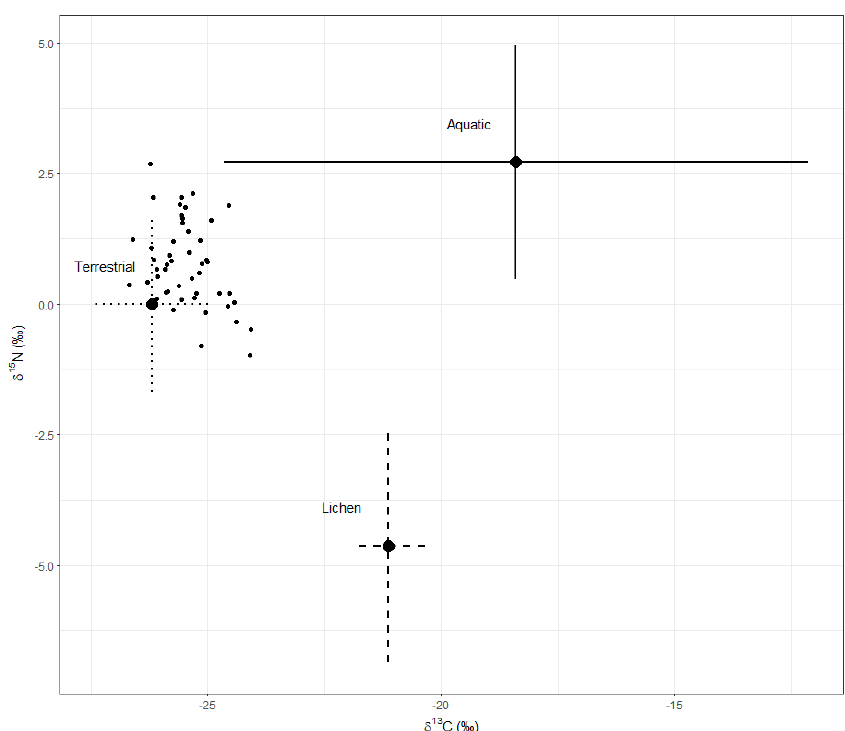
Figure 3. Mean ( ± SD) δ 13 C and δ 15 N in moose forage groups (sources) collected on Isle Royale, Michigan, USA. Small black dots are individual moose values (mixtures). Trophic discrimination factors have been added to the sources (Δ 13 C = 3.0‰, Δ 15 N = 2.7‰).